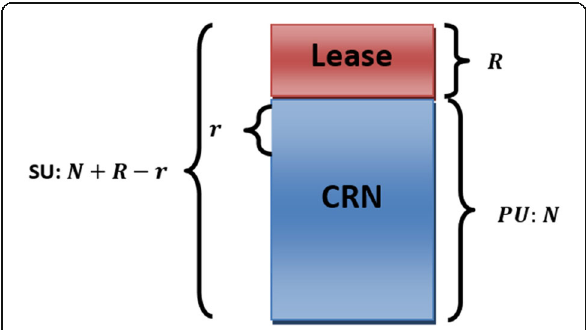
Fig. 2 Resource distribution and allocation for the permanent leasing strategy